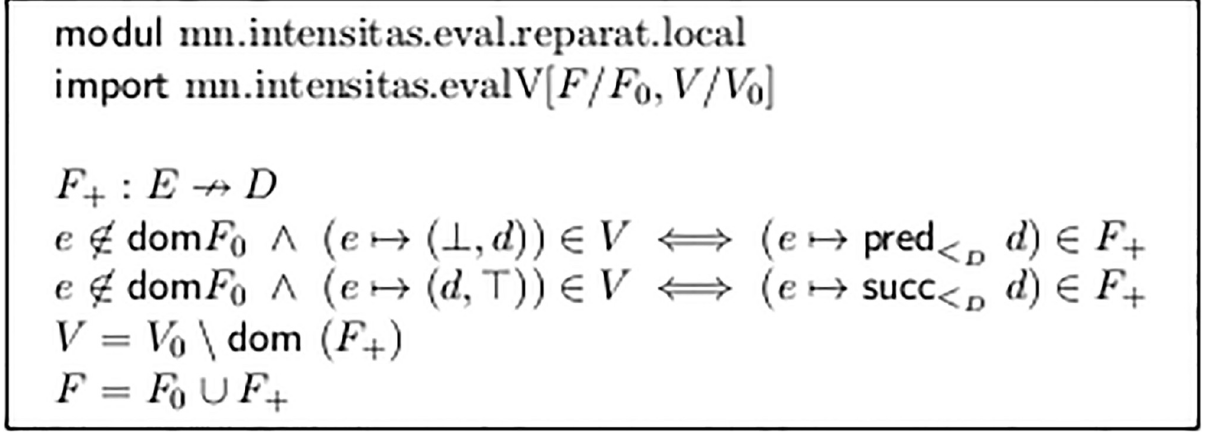
Fig 13. Local repair of partially undefined limits in V